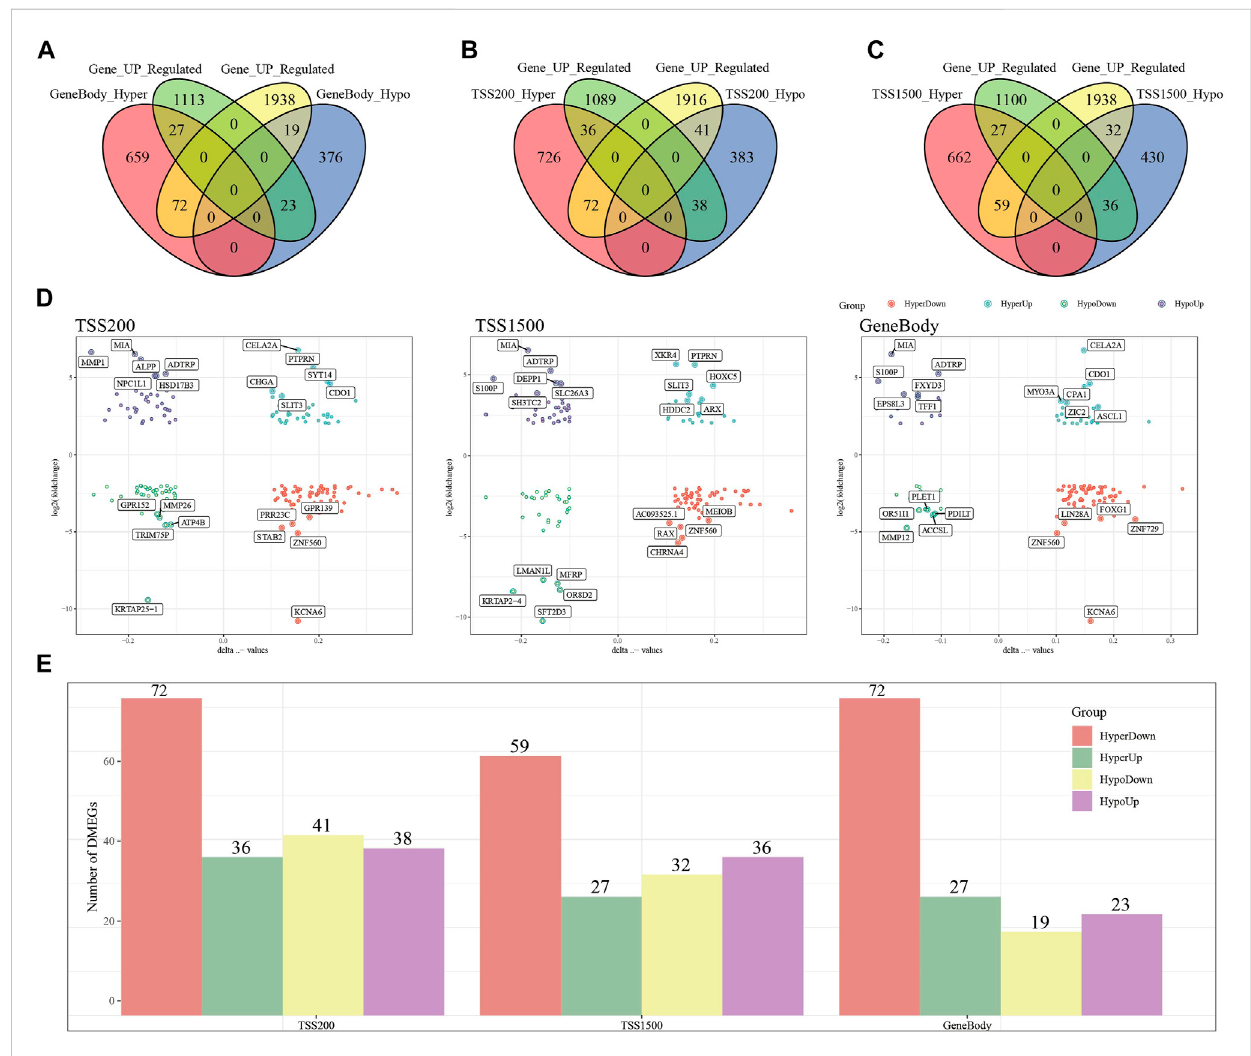
FIGURE 3 Joint analysis of differentially expressed genes and differentially methylated genes. (A) Venn diagram of differentially expressed genes with differentially methylated genes in the GeneBody region. (B) Venn diagram of differentially expressed genes with differentially methylated genes in the TSS200 region. (C) Venn diagrams of differentially expressed genes versus differentially methylated genes within the TSS1500 region. (D) Quadrant plots of differentially expressed genes versus differentially methylated genes within the TSS200, TSS1500, and GeneBody regions. (E) Histogram of four regulatory patterns of differentially expressed genes and differentially methylated genes in TSS200, TS1500, and